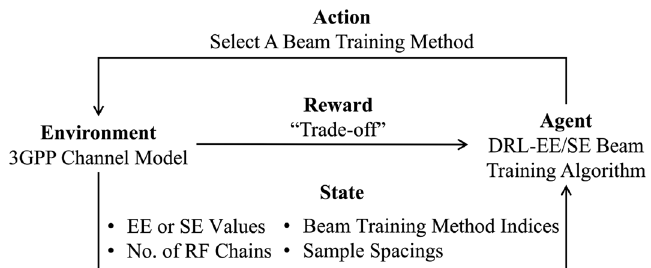
Fig. 4 The RL process in the DRL block for the proposed beam training algorithm